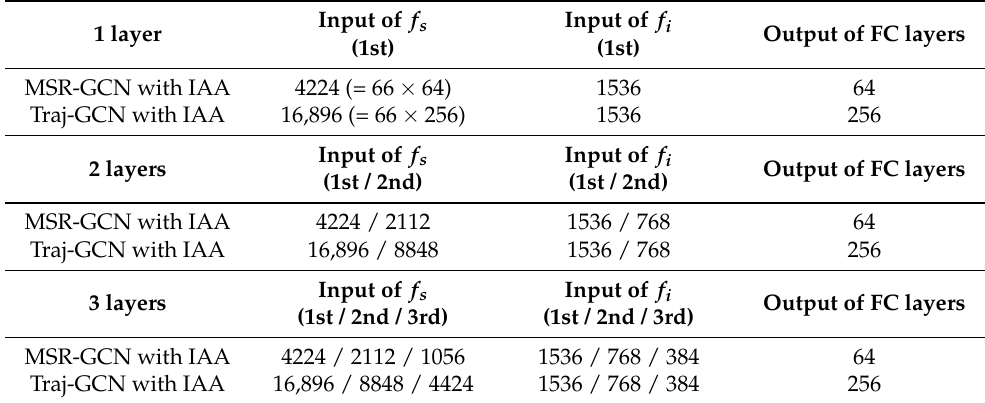
Table 1. The number of parameters for fully connected (FC) layers in our proposed IAA